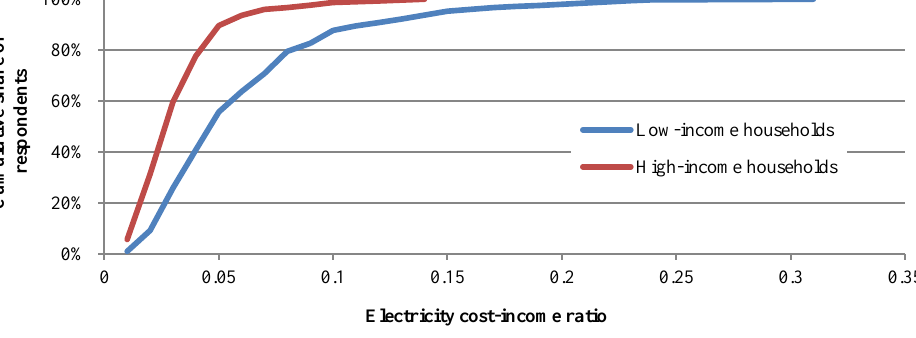
Fig. 5. Relation between the cumulative share of respondents and the electricity cost-income ratio in the low- and high-income